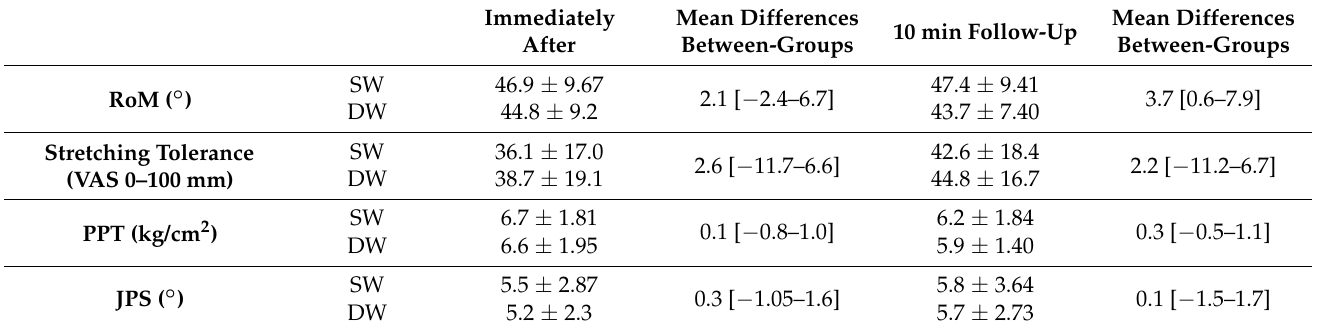
Table 3. Mean and standard deviation (SD) static and dynamic warm-up intervention. Comparisons between different moments. Mean Differences Immediately Mean Differences 10 min Follow-Up After Between-Groups